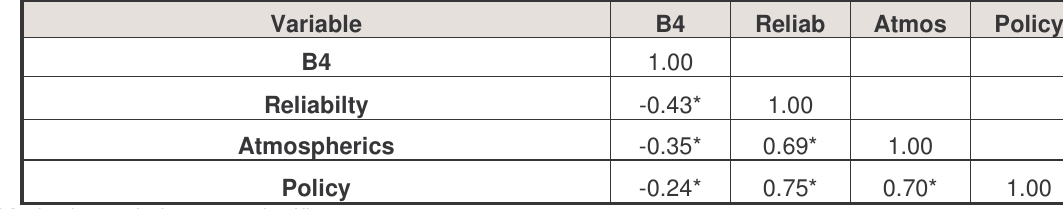
Table 5: Correlation between Complaints about Poor Services and Service Quality Dimensions